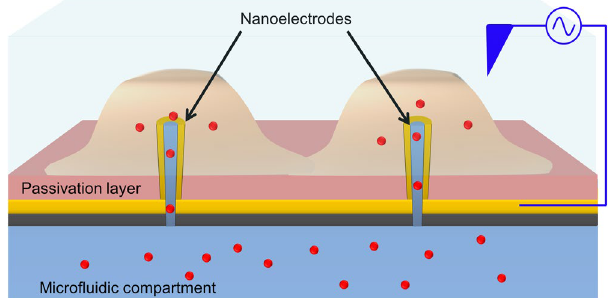
Figure 1. Sketch of the system. 3D hollow nanoelectrodes are protruding outside of a SU8 passivation layer and are connected to a separated microfluidic chamber. The cells adhere on the nanoelectrodes and molecules can flow through the nanochannels after the electrical field is